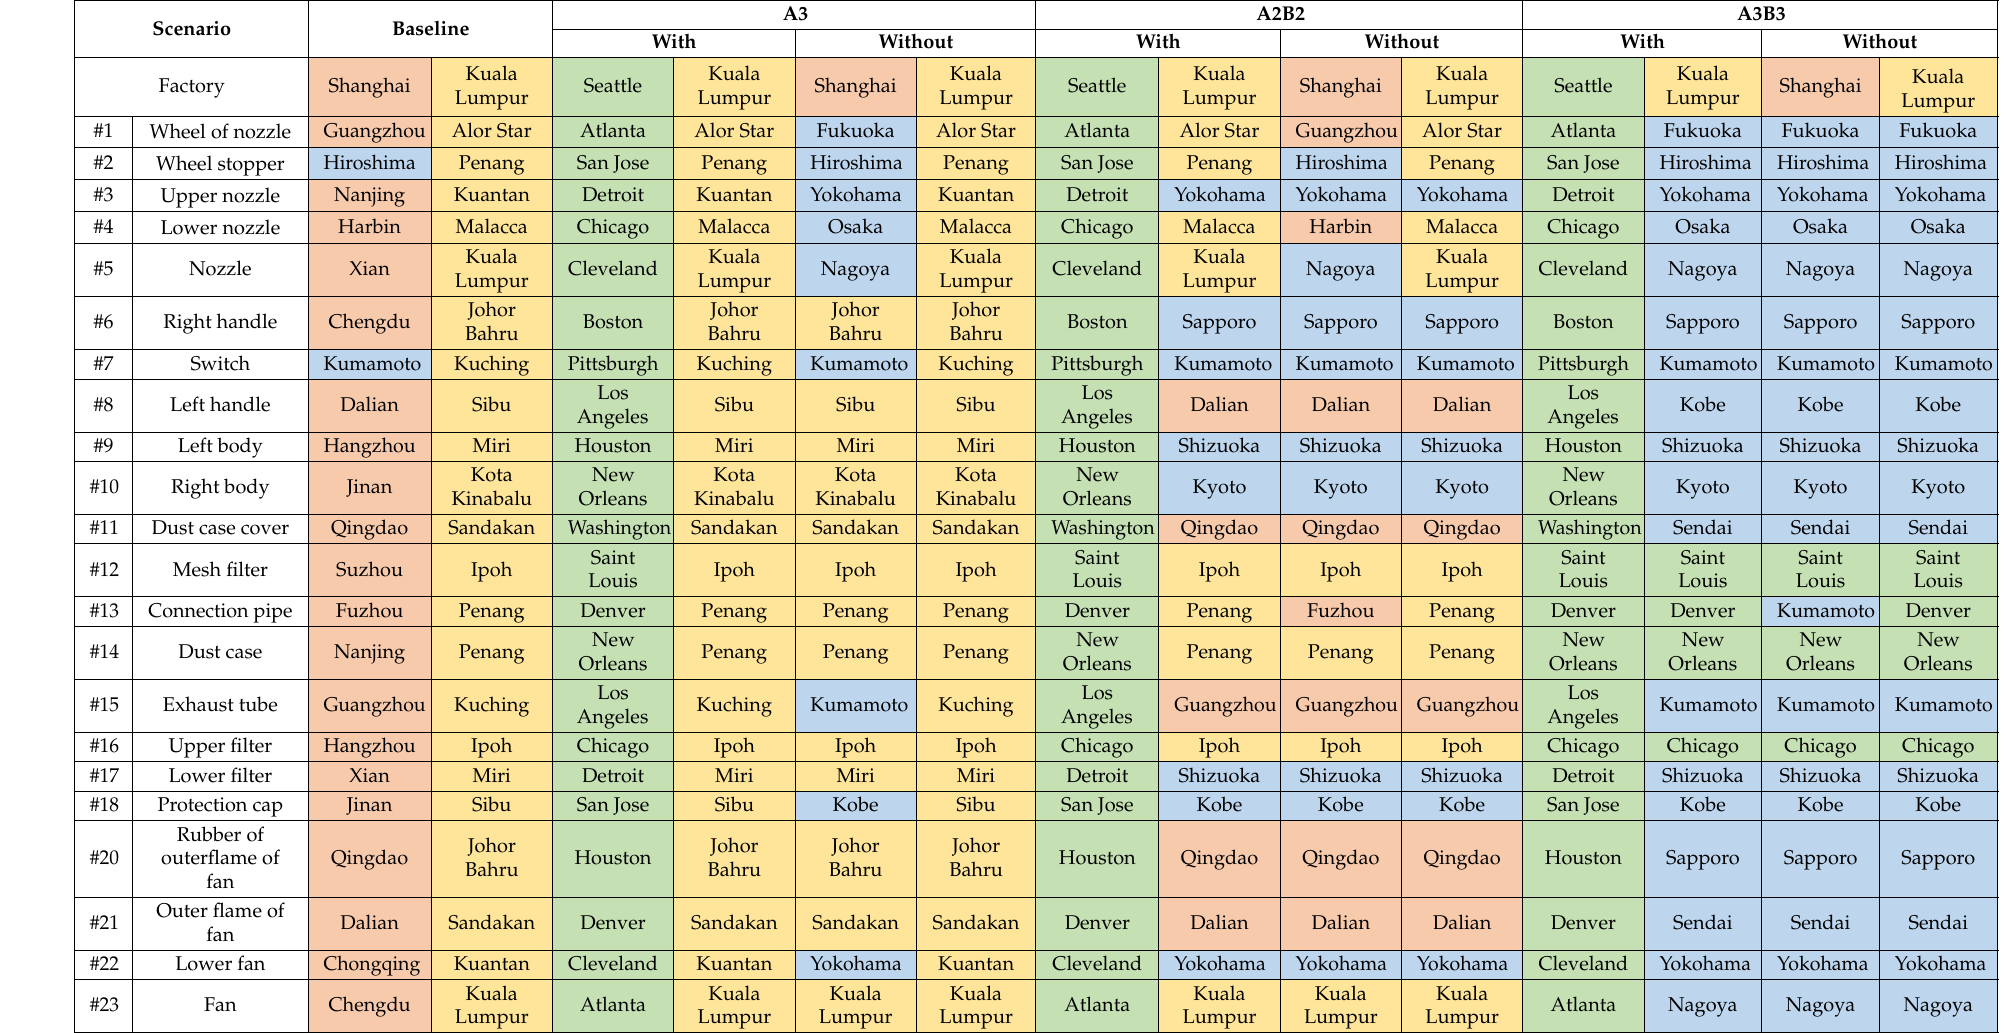
Table 3. Selection of suppliers and factories with and without factory